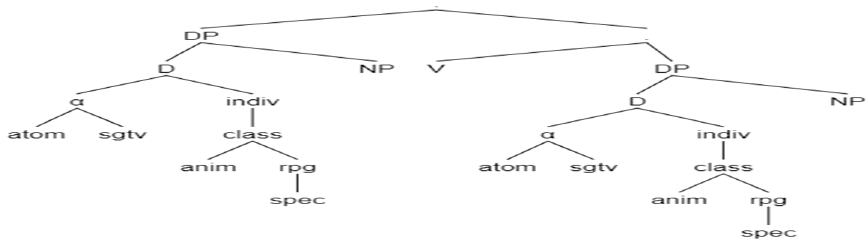
Figure 18. Before insertion of v*, inheritance, Agree, and labeling.